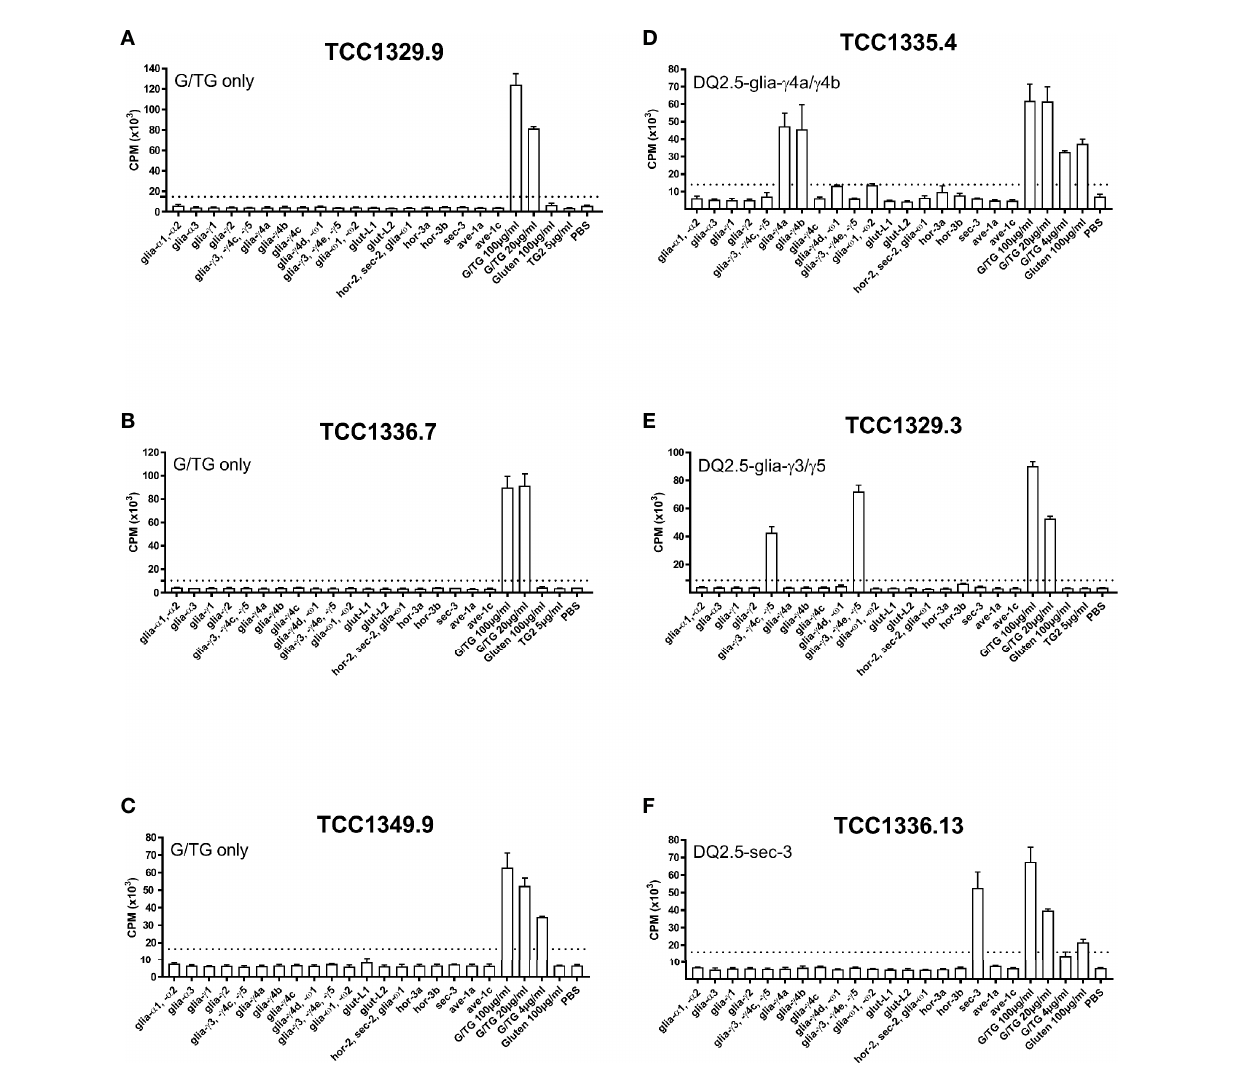
FIGURE 1 | Proliferation of T-cell clones that were speci fi c to TG2-treated gluten only, various DQ2.5-glia- g epitopes, or DQ2.5-sec-3. (A-C) Three T-cell clones from three different patients that responded to TG2-treated gluten digest only. (D) A DQ2.5-glia- g 4a and DQ2.5-glia- g 4b reactive T-cell clone. (E) A DQ2.5-glia- g 3 and DQ2.5-glia- g 5 reactive T-cell clone. (F) A DQ2.5-glia-sec-3 reactive T-cell clone. T-cell proliferation measured by 3 H-thymidine incorporation is visualized by CPM (counts per minute). Bars show average CPM response and standard error of the mean. Dotted line denotes the cut-off set at 2.5 times CPM with PBS. G/TG: TG2- treated gluten digest. All peptides were tested at 10 m M unless otherwise